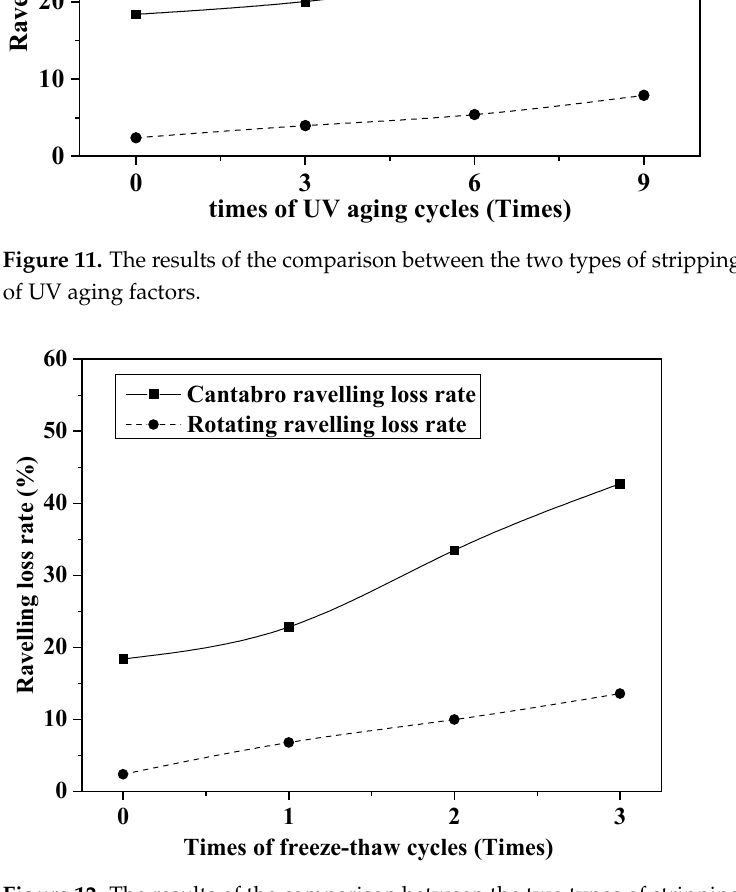
Figure 13. The results of the comparison between the two types of stripping tests under multi-factor influence. The test results show that the ravelling loss rates obtained from the two tests are con- sistent in their changes under the multiple-factor influence of UV aging and freeze–thaw cycles, and the results of the two tests are well correlated. The greater the multiple-factor influence, the larger the ravelling loss rate of asphalt specimens obtained from both tests. The above study confirms that the ravelling loss rates of asphalt specimens obtained from both Rotating Surface Abrasion and Cantabro Abrasion tests are well correlated. The